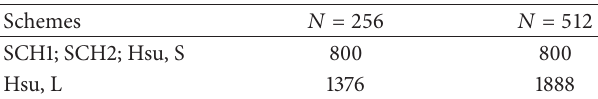
Table 2: Preamble lengths of different schemes (in number of samples).